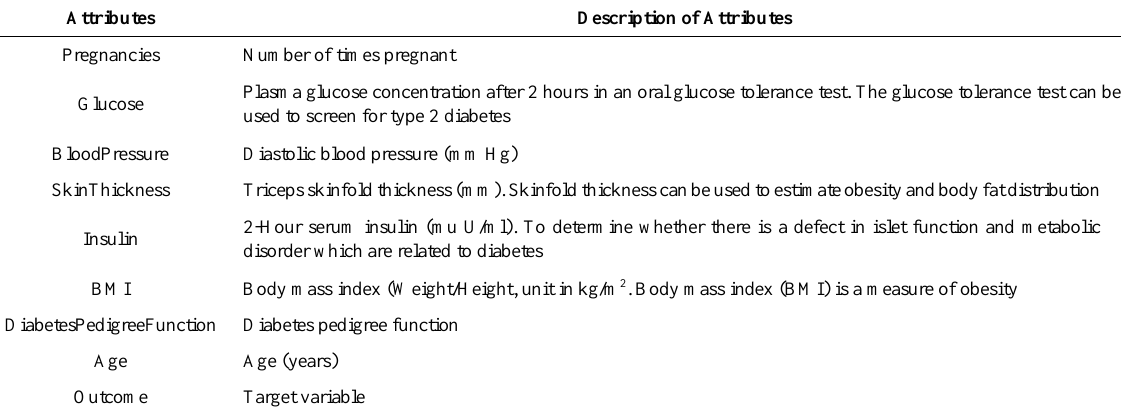
Table 1. Features of the Pima dataset